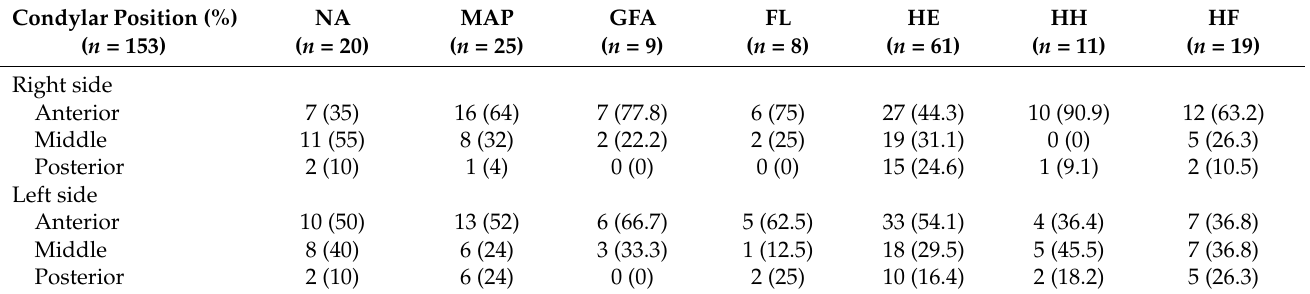
Table 4. Condylar position in FA patients and non-asymmetric subjects without